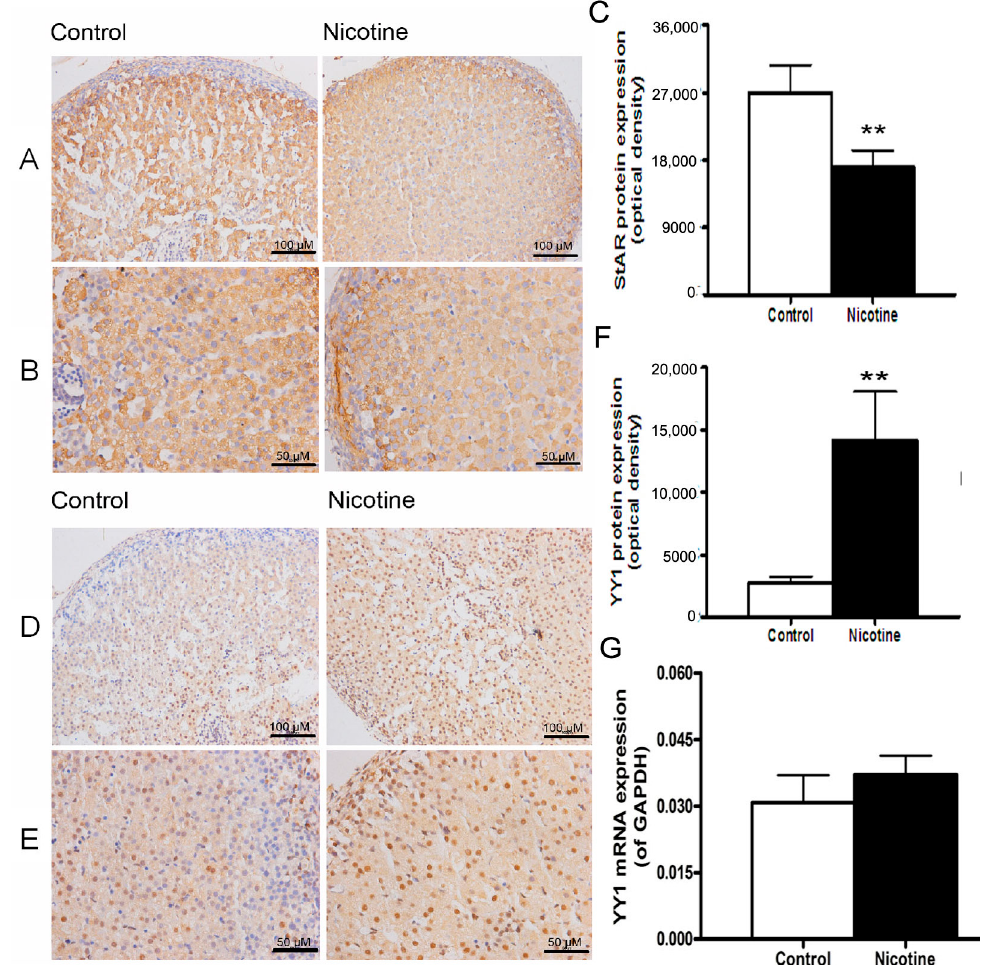
Figure 1. Effects of prenatal nicotine exposure on steroidogenic acute regulatory (StAR) and Yin Yang 1 (YY1) expression in fetal rat adrenal glands. ( A , D ) Representative immunohistochemical staining (×200), brown colors indicate the positive area; ( B , E ) representative immunohistochemical staining (×400); ( C , F ) Mean optical density analysis for StAR and YY1 protein expression; ( G ) quantitative real-time PCR (qRT-PCR) analysis for YY1 mRNA expression. Data are presented as the mean ± standard error of the mean (SEM), n = 5. ** p < 0.01 vs. control.